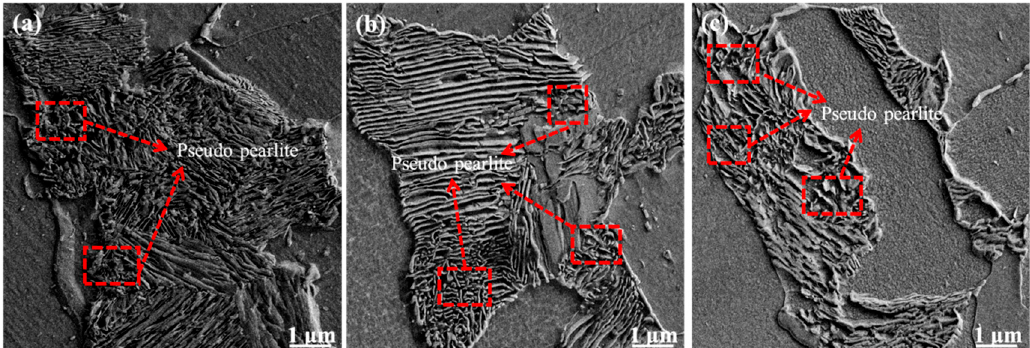
Figure 9. Morphology of pseudo pearlite of experimental steel. ( a ) 650 °C; ( b ) 700 °C; ( c ) 750 °C.